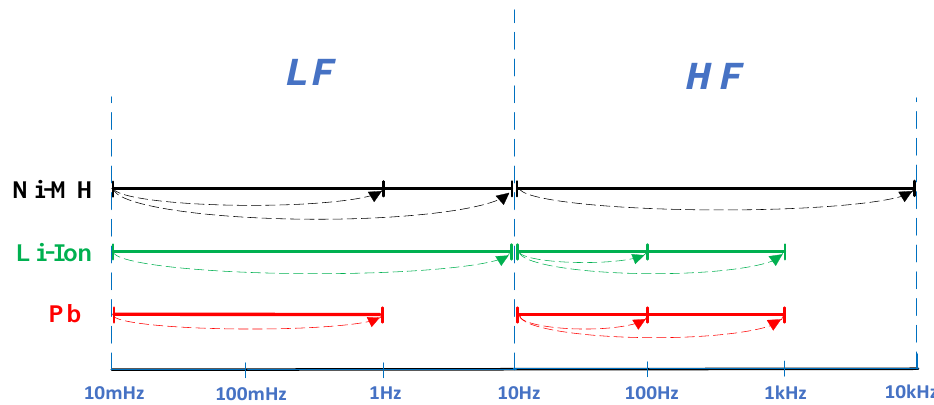
Figure 20. Optimal Frequency Bandwidth for each battery type.